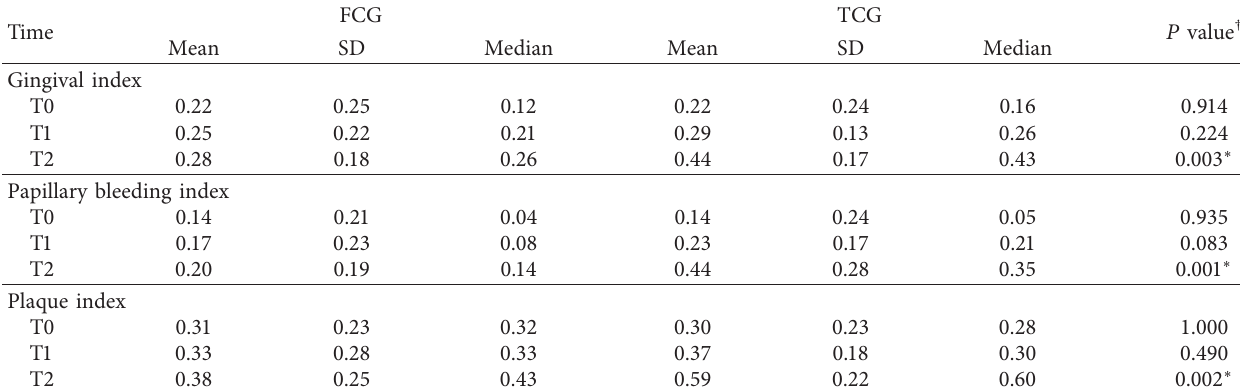
Table 5: Descriptive statistics of the periodontal indices as well as the P values of significance tests. Time